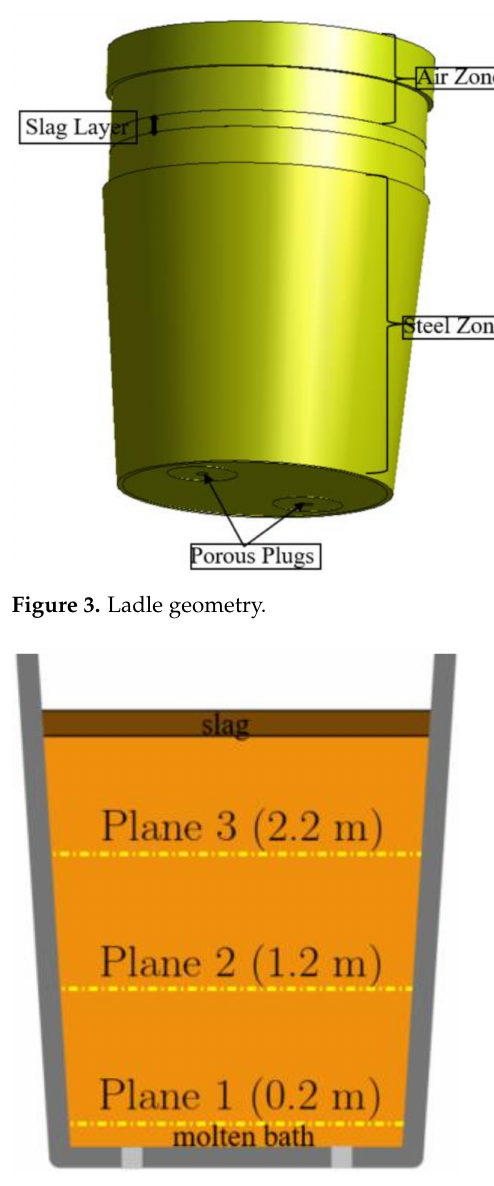
Figure 4. Positions of plane within the steel